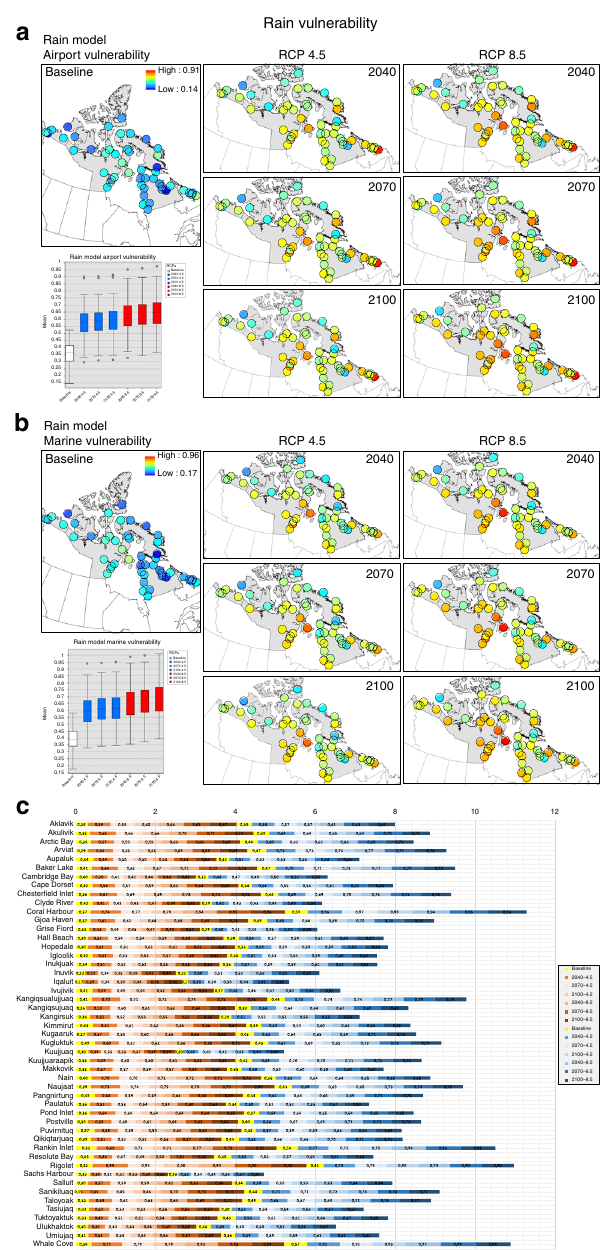
Fig. 4 Rain vulnerability maps. a , b Rain model for airport and marine multiplicative vulnerability equations considering 49 Inuit Nunangat communities. Includes baseline and future RCP 4.5 – 8.5 scenarios (2040, 2070, 2100). Boxplots includes mean, max-min, and outlier values. The x - axis represents the baseline and the subsequent scenarios and y-axis mean vulnerability. The community of Quaqtaq was not included in the rain and snow models due to unavailability of physical features for its entire buffer. c Communities vulnerability graph. Accumulative rain model vulnerability including baseline and future scenarios for the multiplicative equation for 49 Inuit Nunangat communities. Yellow bars represent baseline for both airport and marine models, red bars gradient delimit airport vulnerability and blue bars gradient marine vulnerability. The community of Quaqtaq was not included in the rain and snow models due to unavailability of physical features for its entire buffer